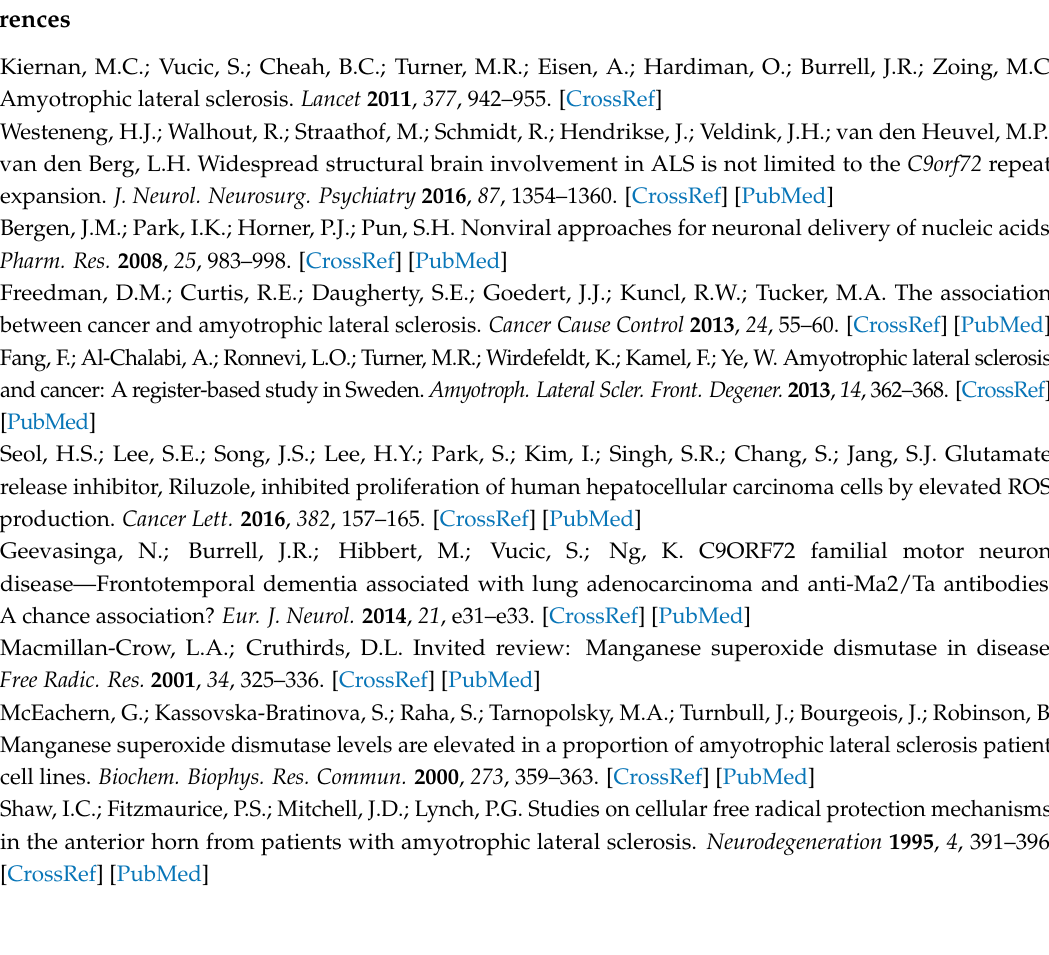
in Table S2, Table S4: Genes associated with significant cancer survival probabilities, Table S5: REACTOME and TFBS enrichment by DAVID for genes in Table